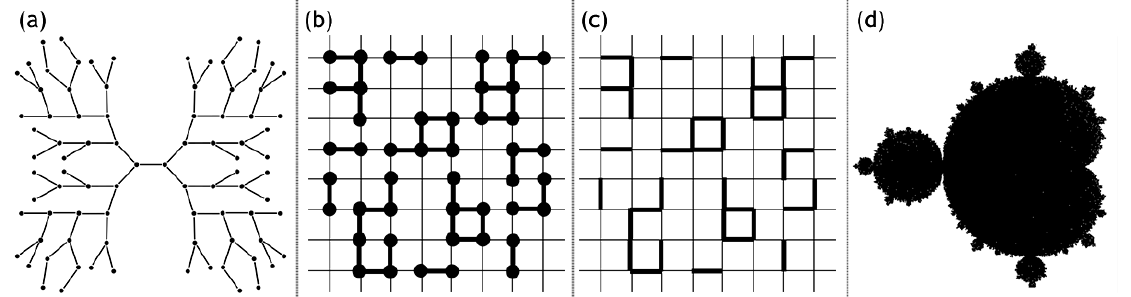
Figure 3. ( a ) Cayley tree or Bethe lattice illustrating the classical or the mean-field theory of gelation. ( b ) Illustration of the simple site percolation model. ( c ) Illustration of the bond percolation model. ( d ) The fractal model as proposed by Mandelbrot.